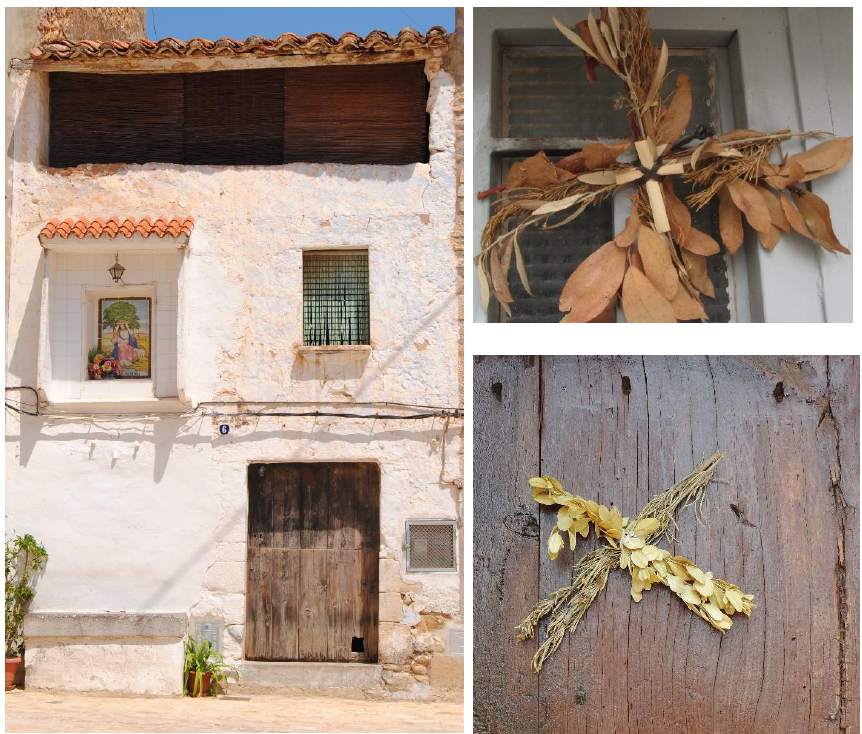
Figure 2. Recognition of intangible elements linked to Intangible, Spiritual, Social and Identity values in Tables 2 and 3. Ornamental practices at the time of interviews in the region of Cuenca. Phase 3 (2020). Source: Author.